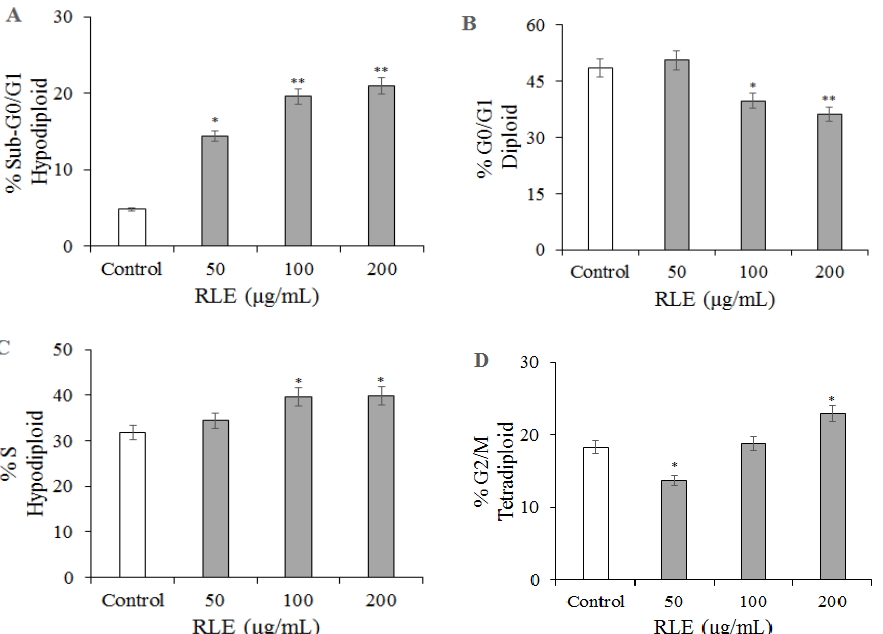
Figure 7. Effect of RLE on the cell cycle distribution of HT-29 was detected by flow cytometry (`x ± SD, n = 3). * p < 0.05 ** p < 0.01 vs. control group.